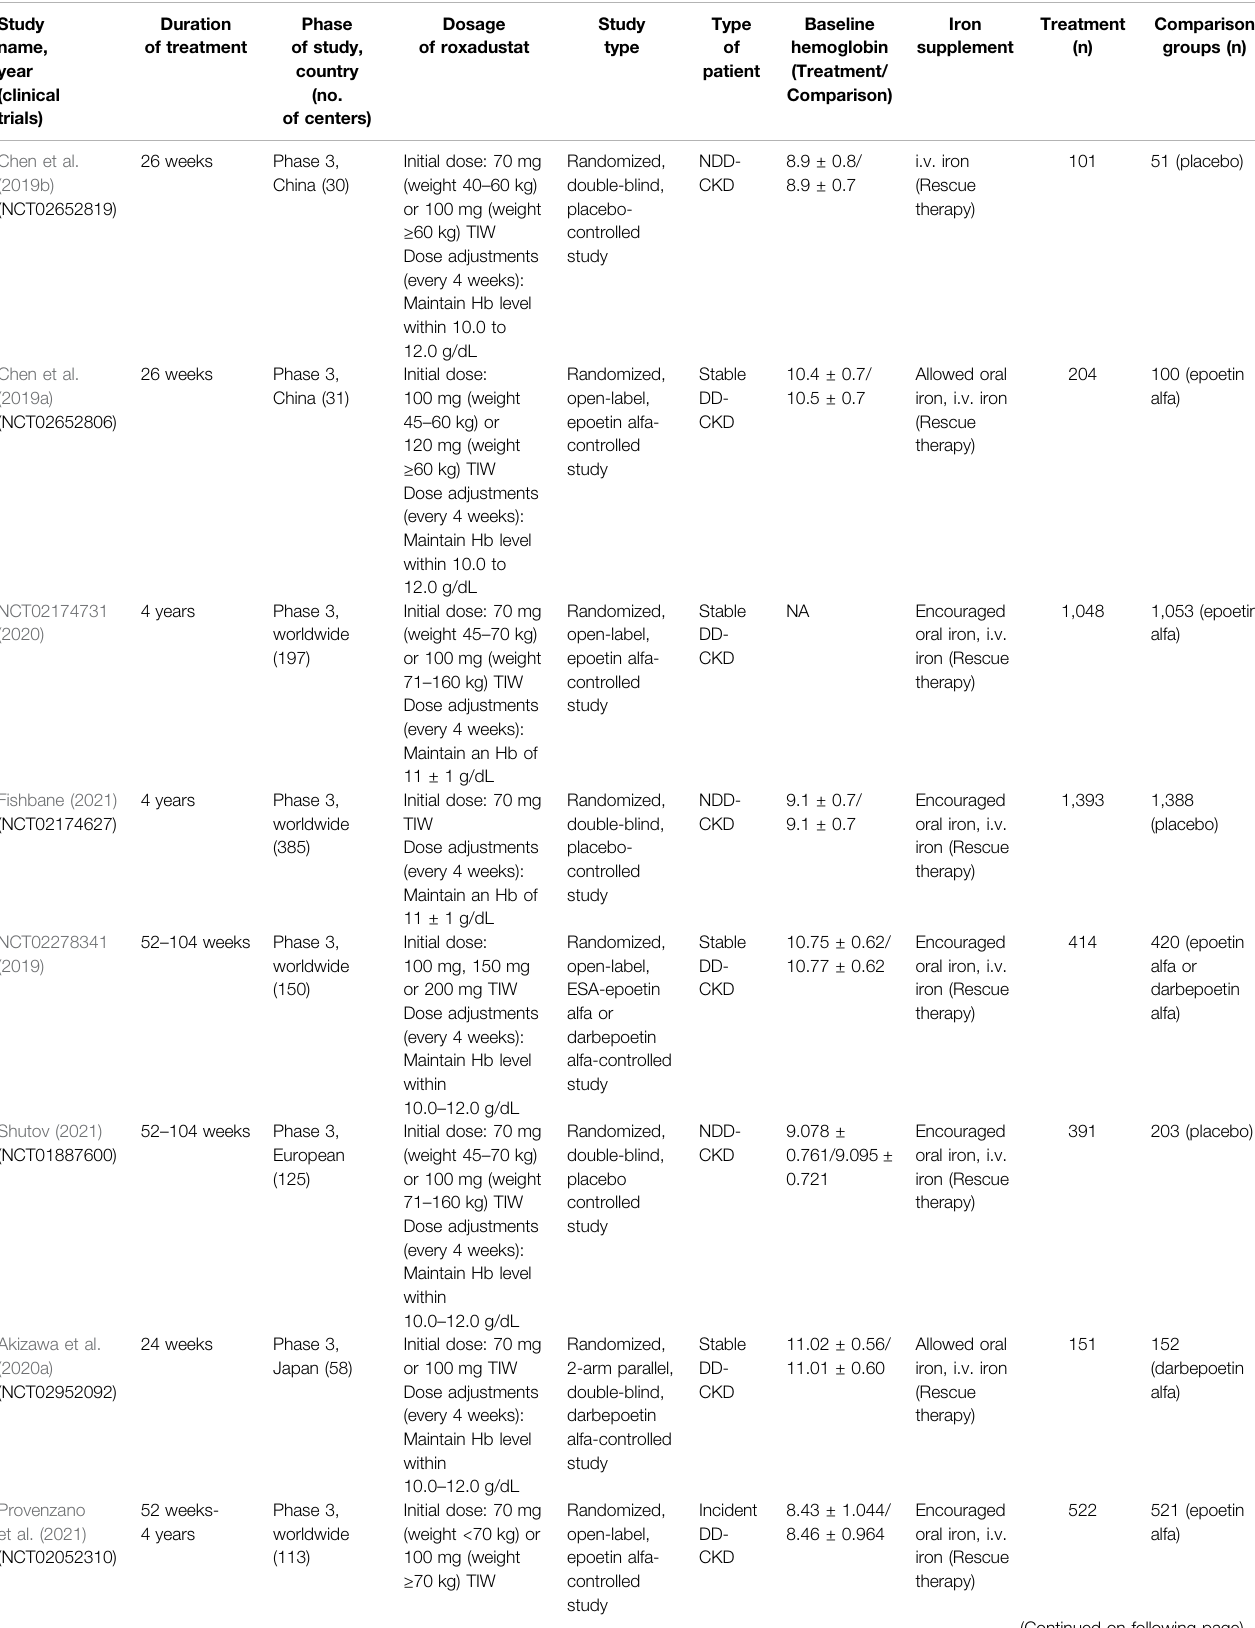
TABLE 1 | Characteristics of included